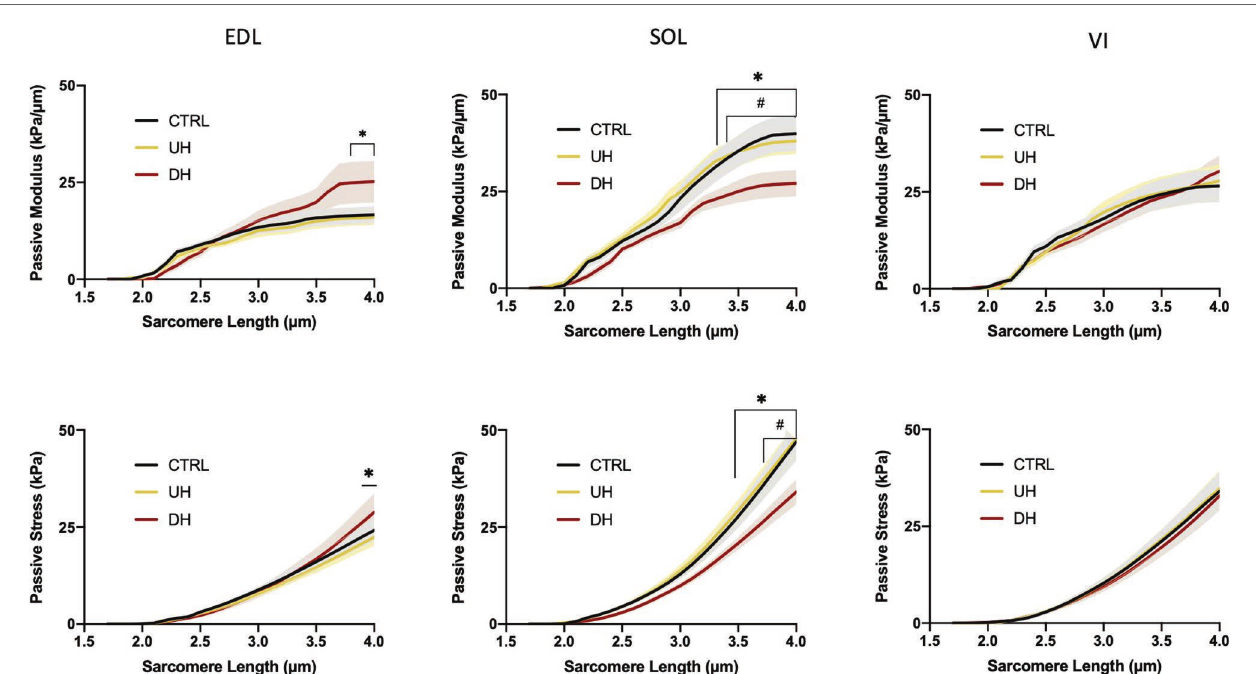
FIGURE 2 | Mean (solid lines) and SEM (shaded) single muscle fiber passive elastic modulus (top panel) and stress (bottom panel) for each muscle [extensor digitorum longus (EDL), soleus (SOL), and vastus intermedius (VI)] across the range of SLs. * indicates statistical difference between DH and UH groups. # indicates statistical difference between control (CTRL) and downhill (DH) groups. ( n = 185; p <